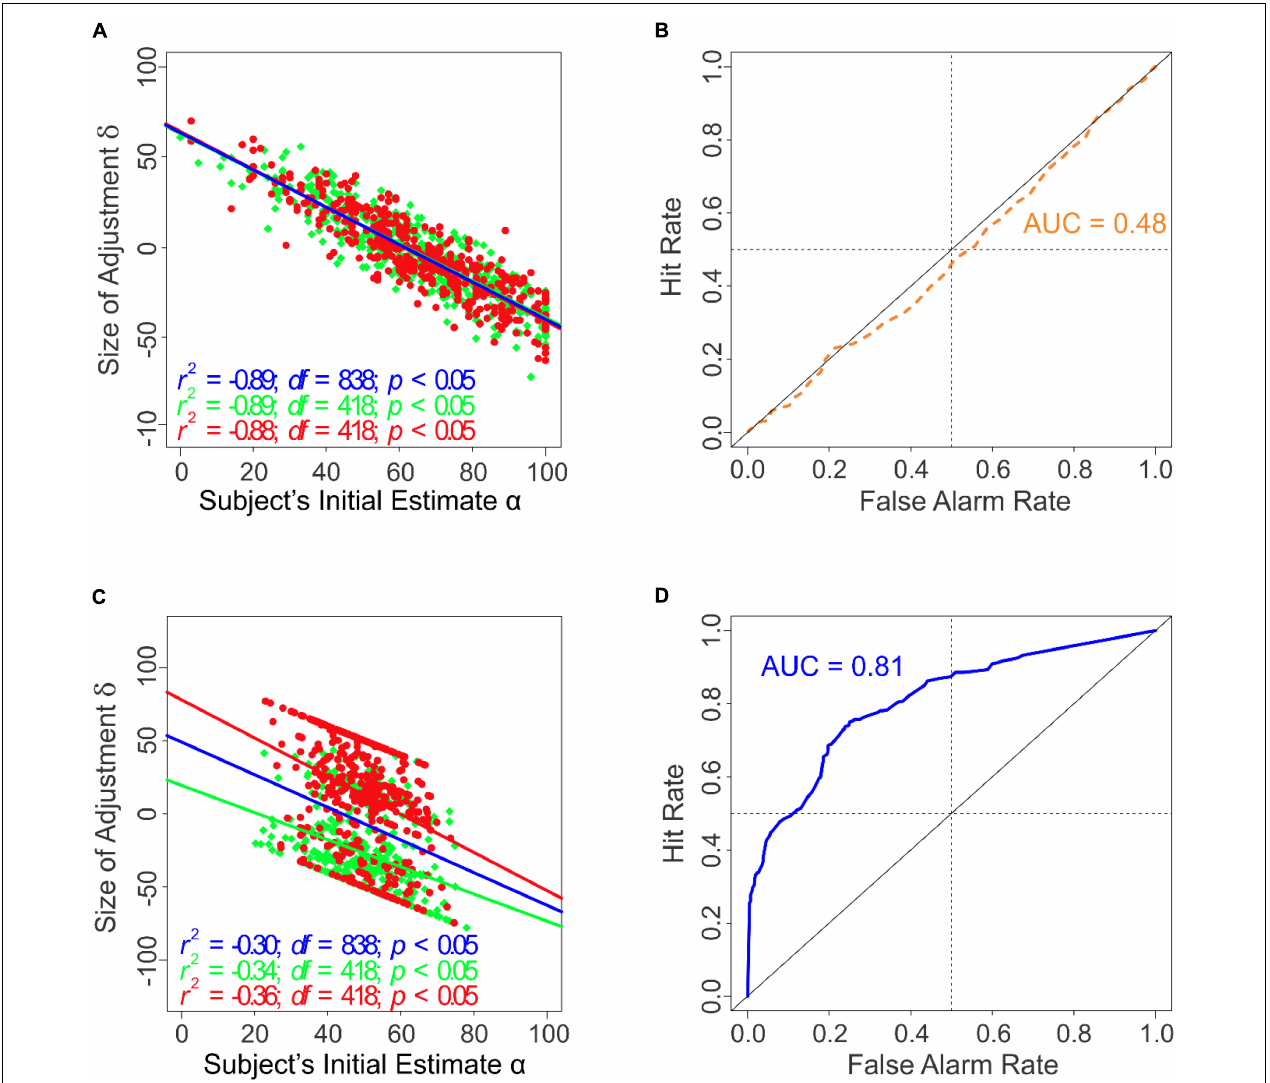
FIGURE 5 | Task performance of subjects with or without anchoring information in Experiment 3. The various panels in this figure are drawn using the same plotting conventions as the corresponding panels in earlier figures. (A) The magnitude of the subjects’ adjustment δ as a function of their initial estimate α in the absence of anchoring information. Note that the blue regression line in this panel largely overlaps, and therefore obscures, the red and the green regression lines. (B) ROC analysis of the subjects’ final estimates in the presence of anchoring information. (C) The magnitude of the subjects’ adjustment δ as a function of their initial estimate α in the absence of anchoring information. (D) ROC analysis of the subjects’ final estimates in the absence of anchoring